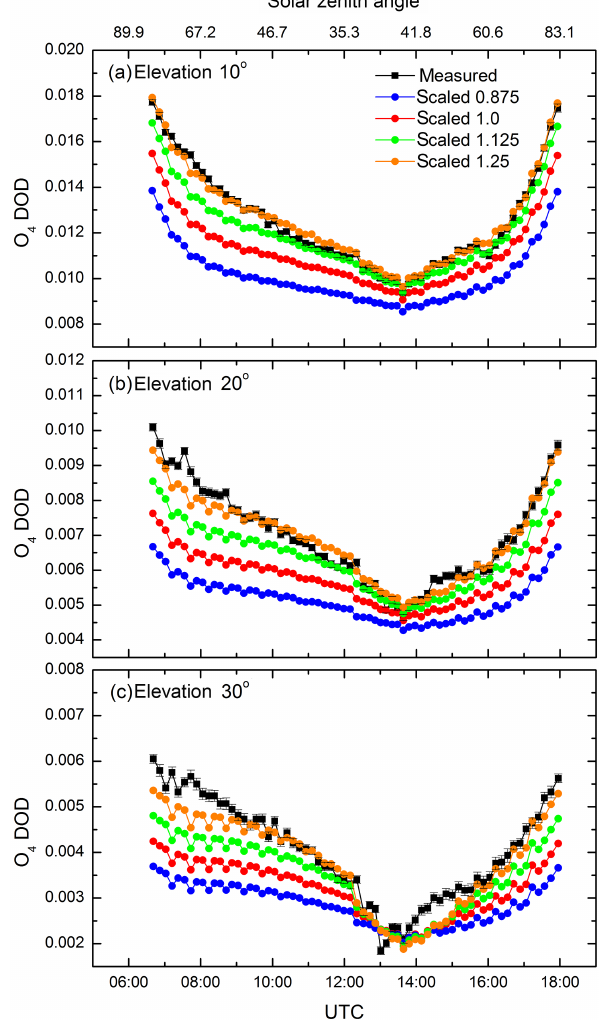
Figure 2. Diurnal variation of the measured O 4 DODs and simu- lated O 4 DODs with different scaling factors at elevation angles of 10, 20 and 30 ◦ on 4 April